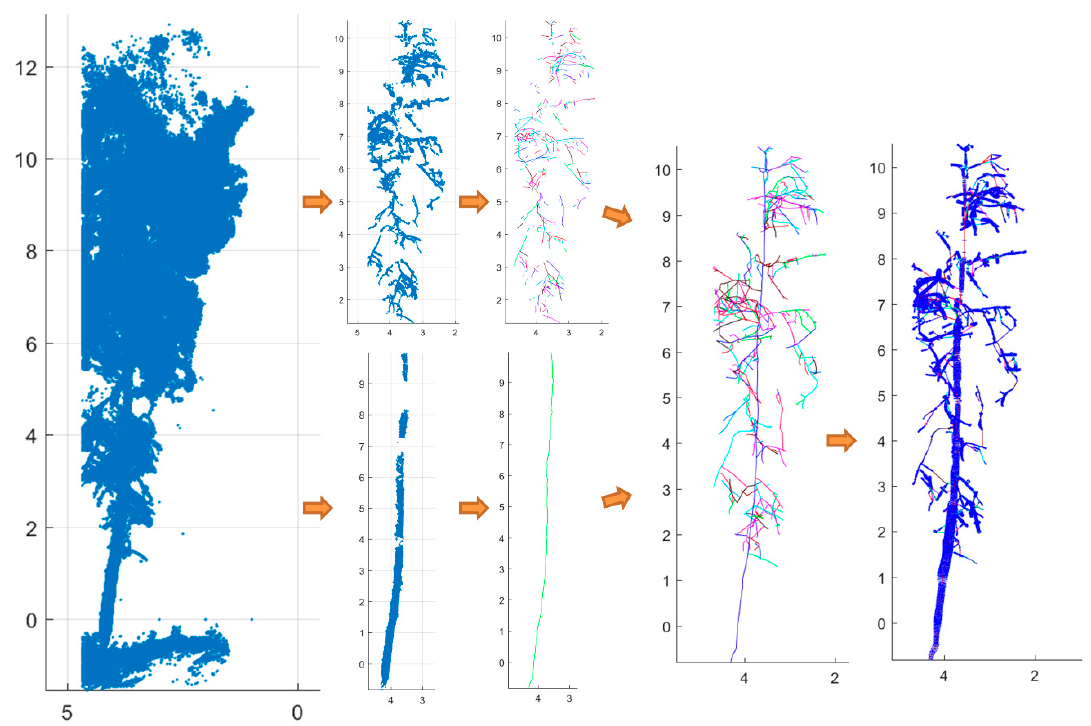
Figure 10. Illustration of individual-tree QSM process for ‘aspen 7’. From left to right are raw points, stem and branch points filtered from the 3-D FCN model, stem and branch curve in random colors, tree curve connection in random colors, and tree curve overlaid with cross-section circles.